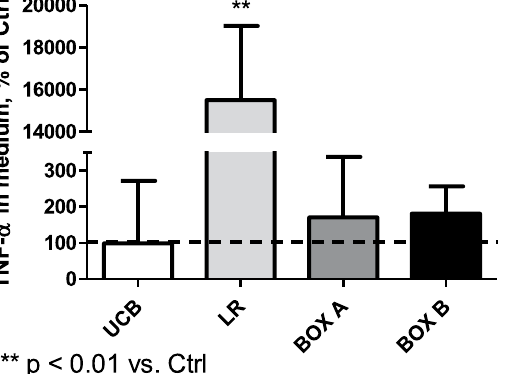
Figure 5. The effect of LR and other bilirubin photo-oxidative products on TNF- α production by organotypic rat hippocampal slices. Four h exposure to UCB, LR, BOX A, or BOX B (25 μ mol/L). Controls expressed as